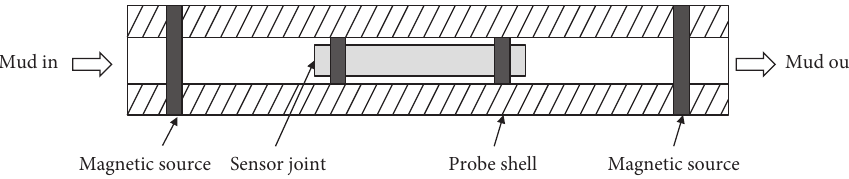
Figure 3: The overall structure of the probe.